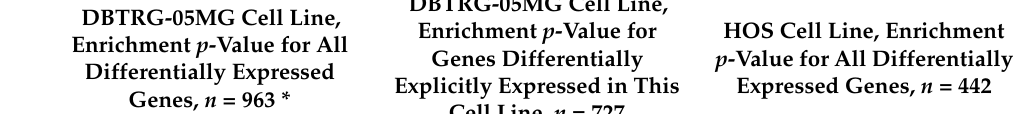
Hallmark Pathway